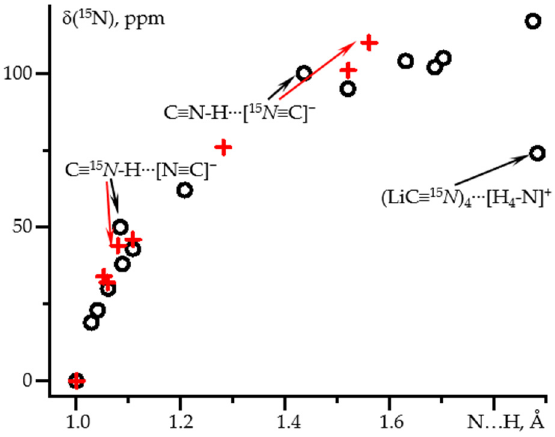
Figure 2. δ iso ( 15 N) as a function of the N-H distance in hydrogen-bonded complexes of C ≡ 15 N- 1 H obtained at different approximations and PCM = water. Geometry optimization at the wB97XD/def2tzvp and NMR at the GIAO wB97XD/pcJ-2 approximations (black circles). Geometry optimization at the MP2/def2qzvpp and NMR at the GIAO wB97XD/pcJ-3 approximations (red crosses).